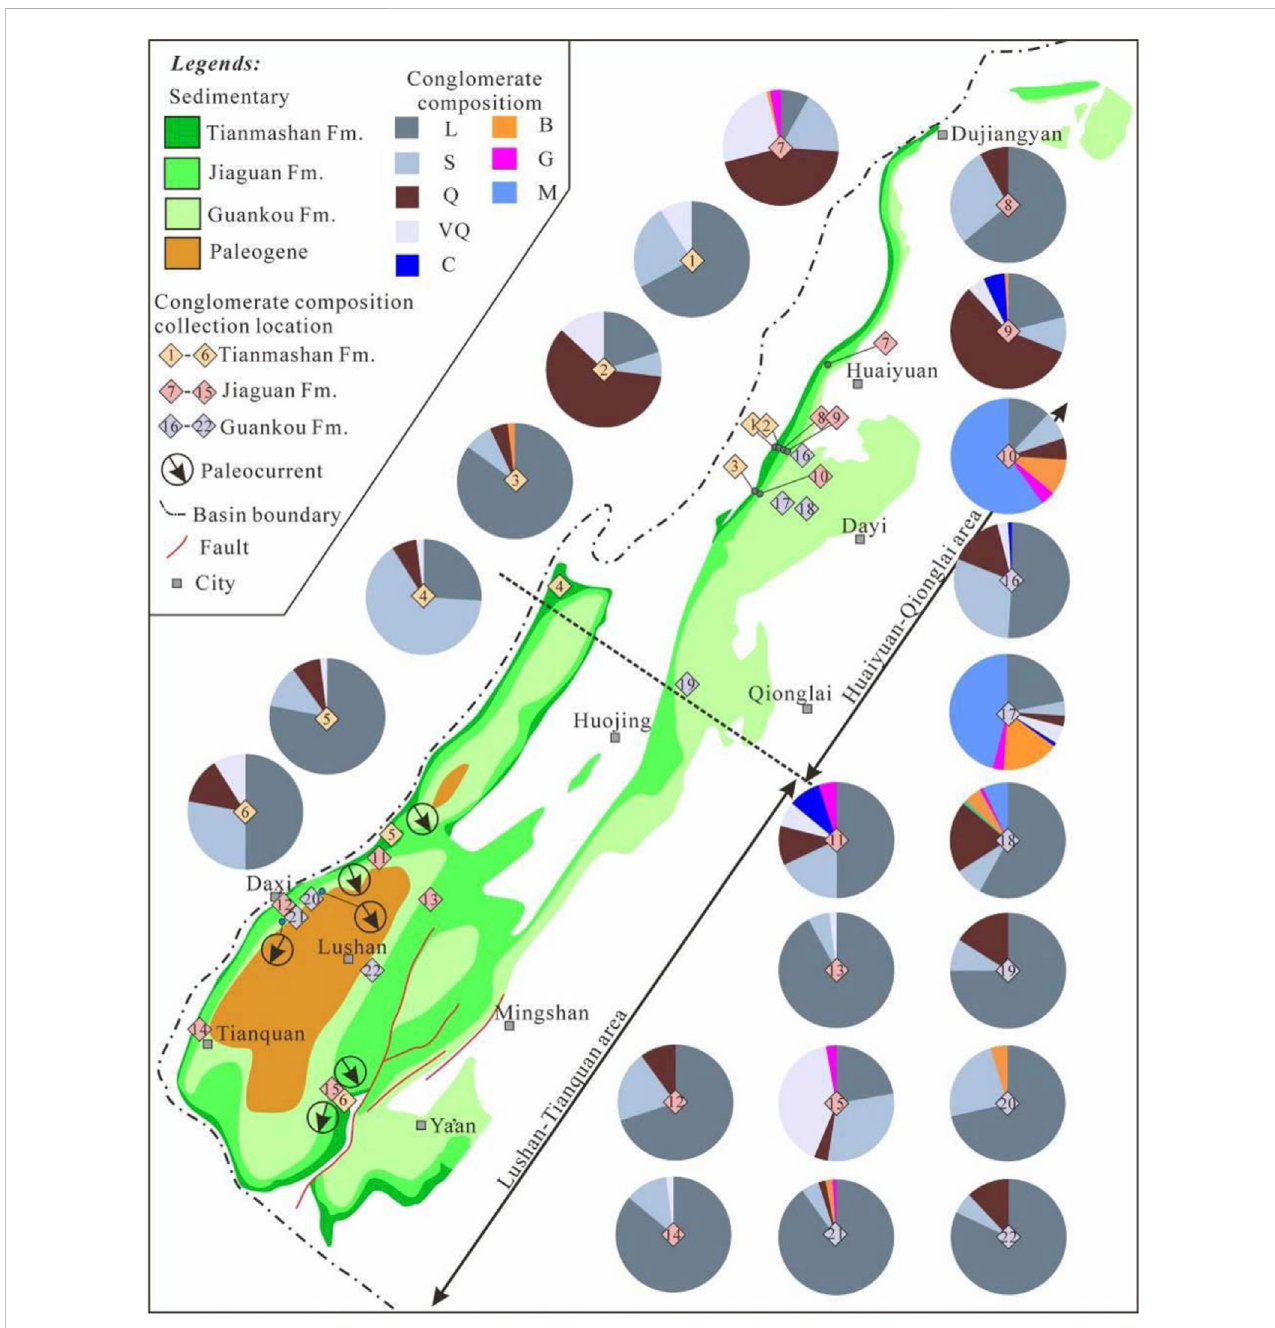
FIGURE 5 The pie charts showing clasts composition of conglomerate from the southwest corner of Sichuan Basin. Clast types in the Cretaceous sandstones: L -limestone, S-sandstone, Q-quartzite, VQ-vein quartz, C-chert, B-basalt, G-granite, M-metamorphic. Clasts composition data from Chengdu Institute of Geology and Mineral Resources (CGMR). (1979), Zeng et al. (2004), Ji and Li, 1995, Li and Ji (1993), Gou (2001), and this